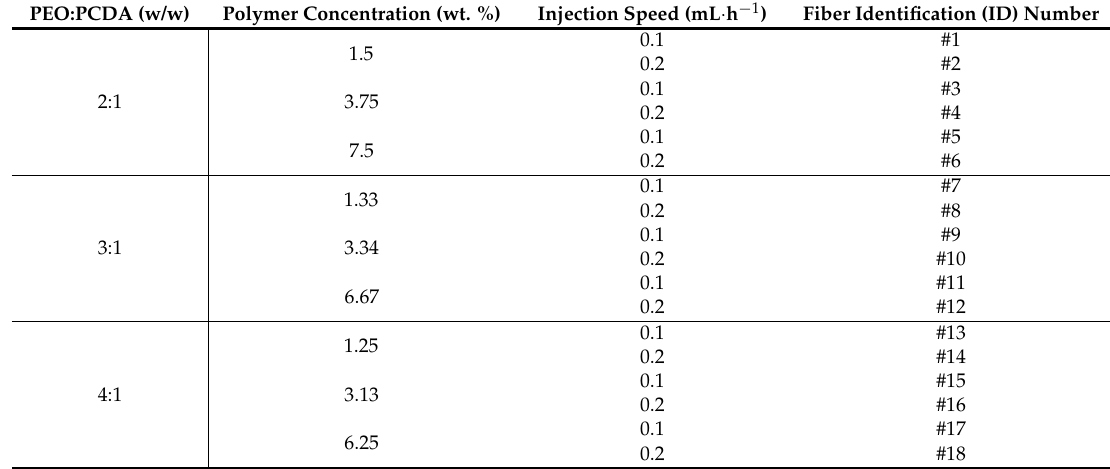
Table 1. Electrospinning design for preparing Polyethylene oxide (PEO)-Pentacosadiynoic acid (PCDA)